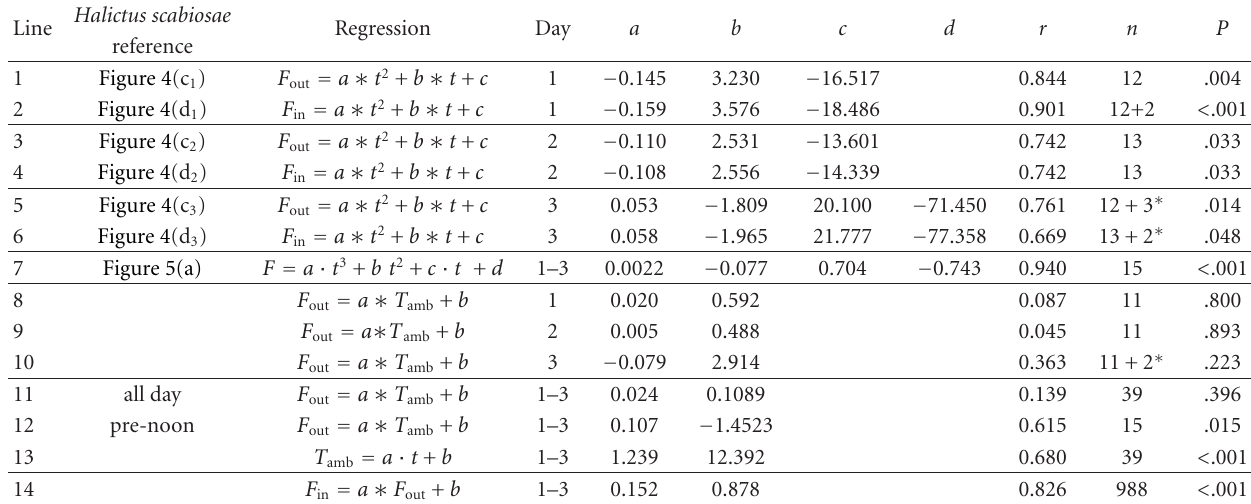
Table 1: Regression functions of foraging activities of Halictus scabiosae . F out and F in : outgoing and incoming foraging activity (per nest and per 30minutes observation session); F = ( F out + F in ) / 2; t : daytime in hours; T amb , ambient temperature in ◦ C; a–d: regression coe ffi cients, r : correlation coe ffi cient. ∗ Additional virtual values (marked with +) were introduced for the calculation of the regression